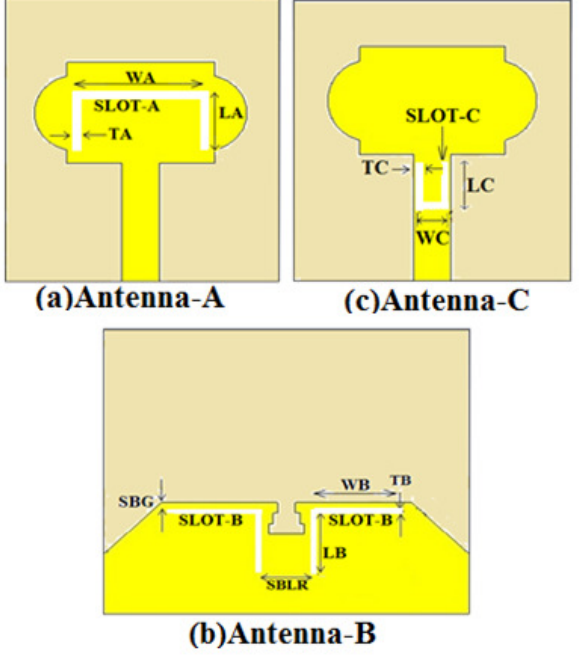
Figure 3: (a) Antenna-A with slot-A in patch, (b) Antenna-B with pair of slot-B in ground plane, and (c) Antenna-C with slot-C in feed line.